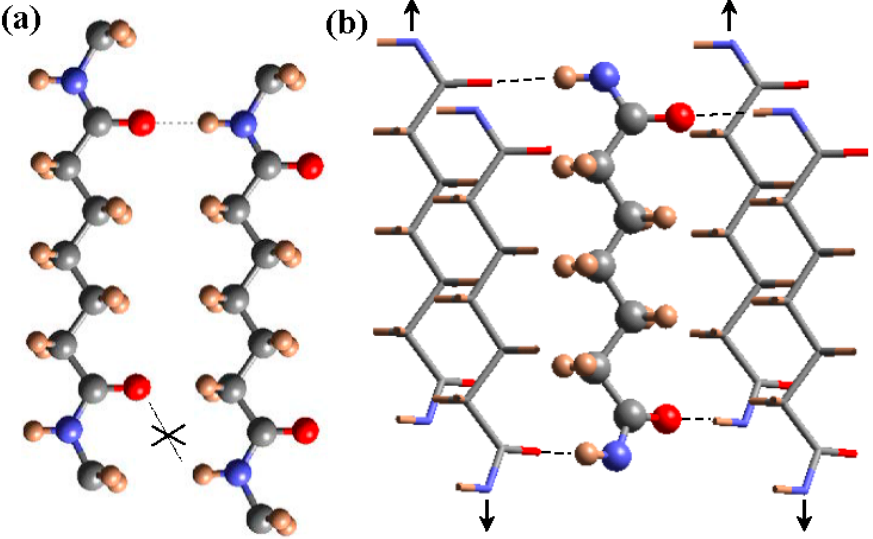
Figure 4. Scheme of the unfavorable hydrogen bonding geometry between odd carboxamide (i.e., pimelamide) units having an all-trans conformation ( a ); and the favorable interaction established according to the proposed structure where hydrogen bonds are established along two directions ( b ). For shake of clarity different representations are employed for the external and inner chains of the unit cell and a shorter dicarboxylic unit (i.e., pimelamide) has been considered. Arrows indicate the shift of neighboring chains with respect the central one. Color code: nitrogen, blue; oxygen, red; carbon, gray; hydrogen, brown. Reproduced with permission from [36], copyright 2015 Elsevier.